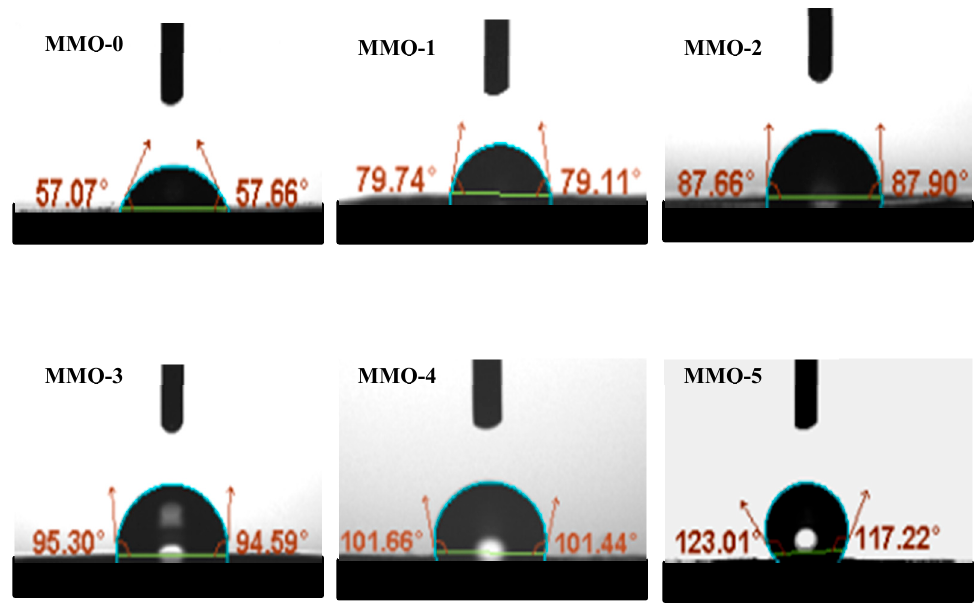
Figure 5. The contact angle of the RTV silicone rubber.